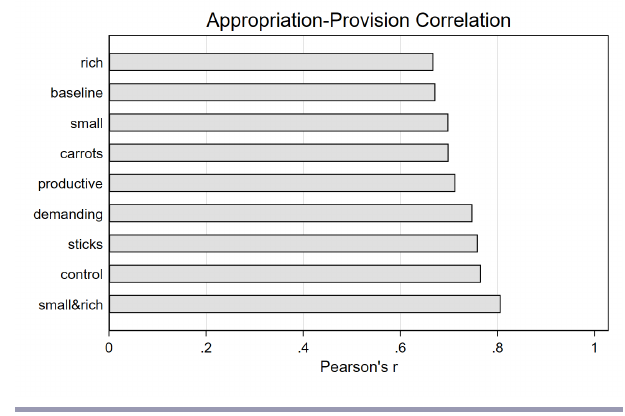
Fig. 3. Correlations between appropriation and provision behavior across a baseline specification and eight